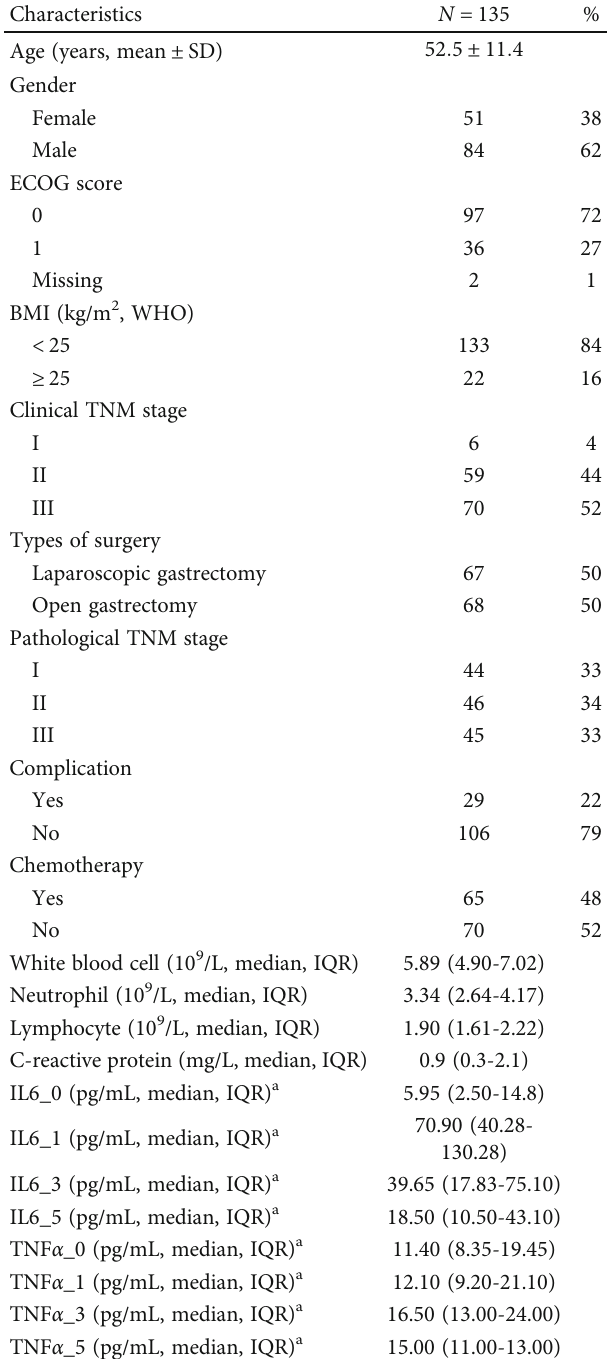
Table 1: Baseline characteristics of patients with gastric cancer.